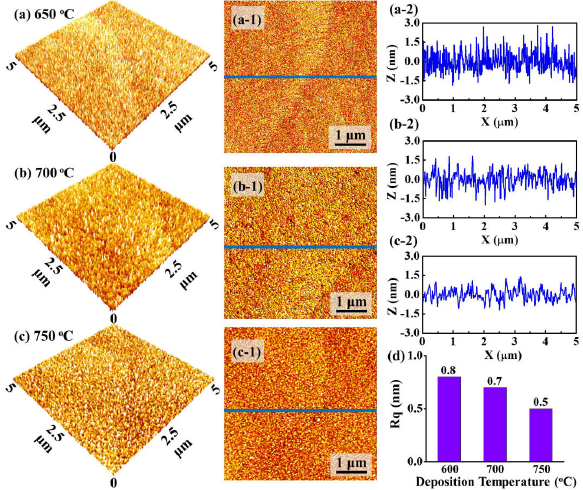
Figure 1. ( a ) X-ray diffraction (XRD) spectra of the pristine MgO substrate and PLZT thin films fabricated at 650, 700 and 750 ◦ C; and ( b ) the scheme of the PLZT crystal structure.